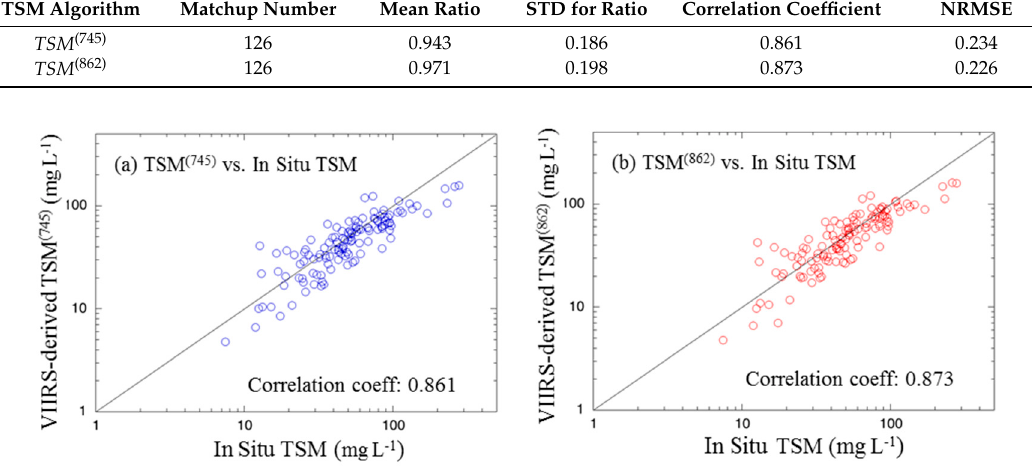
Figure 4. Scatter plots of ( a ) VIIRS b bp (745)-derived TSM (745) versus in situ-measured TSM and ( b ) VIIRS b bp (862)-derived TSM (862) versus in situ-measured TSM.